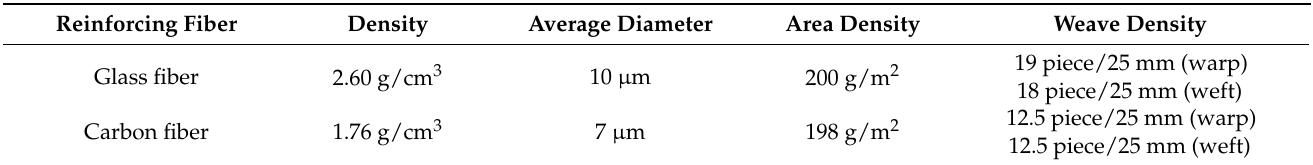
Table 2. The physical properties of reinforcing